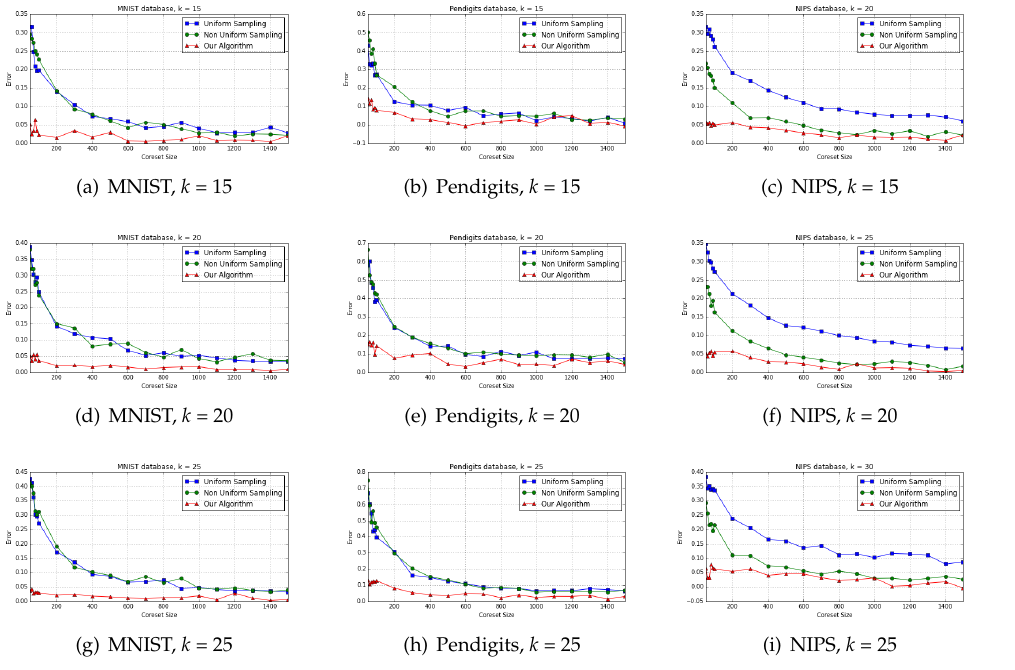
Figure 2. Offline coresets computation for small datasets (uniform sampling, non uniform sampling and our